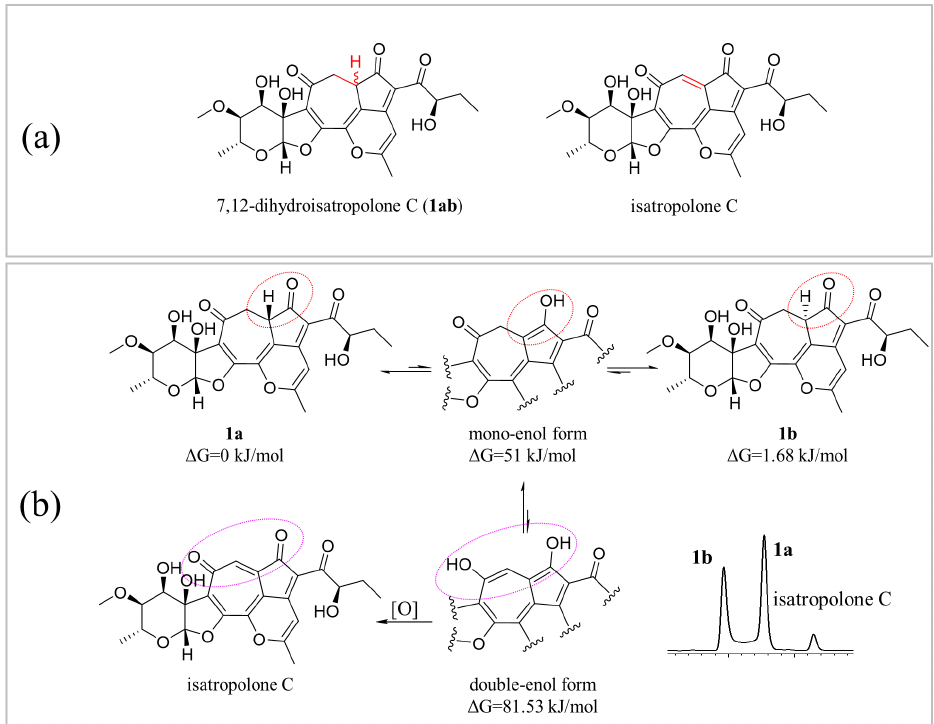
Figure 1. The structure of 7,12-dihydroisatropolone C (H 2 ITC, 1ab ) and its oxidation to isatropolone C (ITC). ( a ) 7,12-dihydroisatropolone C and isatropolone C. ( b ) Keto-enol tautomerization of 1a and 1b in H 2 ITC, and their spontaneous oxidation to isatropolone C. The HPLC trace showed the pair peaks of H 2 ITC ( 1ab ) and a small isatropolone C peak.